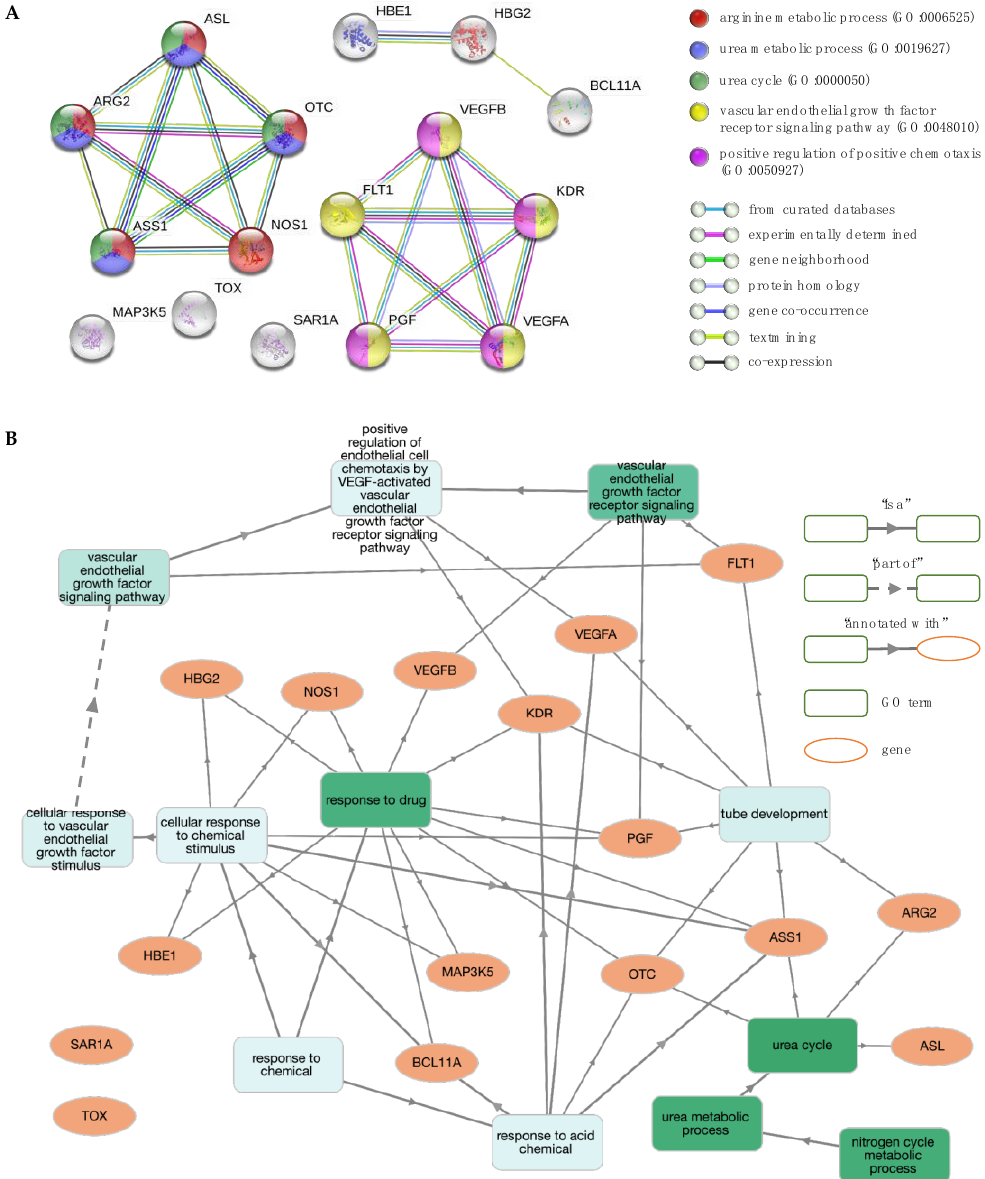
Figure 5. Network and enrichment analysis for Hb F levels and Hb F response to hydroxyurea (HU). ( A ) The protein–protein interaction (PPI) network contains 16 nodes (proteins; circles) connected by edges (protein–protein interactions). The most significant gene ontology (GO) biological process (BP) terms are shown. ( B ) GO BP enrichment analysis using GOnet ( q value ≤0.01; p value ≤7.88 × 10 –6 ). Green colour intensifies as the significance level of enrichment decreases.